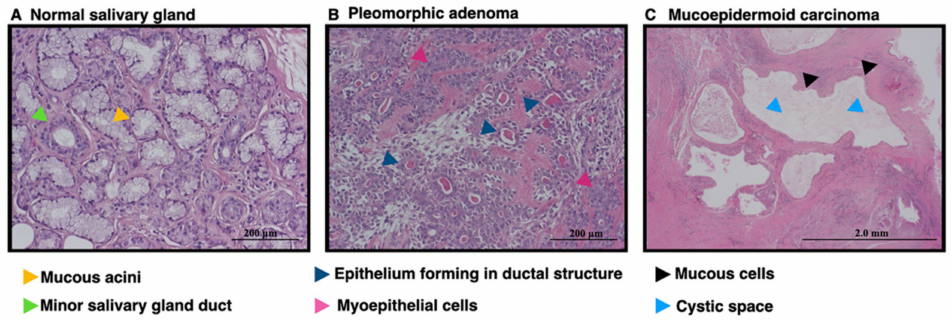
Figure 1. The hematoxylin and eosin (HE) staining images. ( A – C ) The HE staining indicated the characteristics of a normal salivary gland (bar = 200 µ m), pleomorphic adenoma (bar = 200 µ m), and mucoepidermoid carcinoma (bar = 2